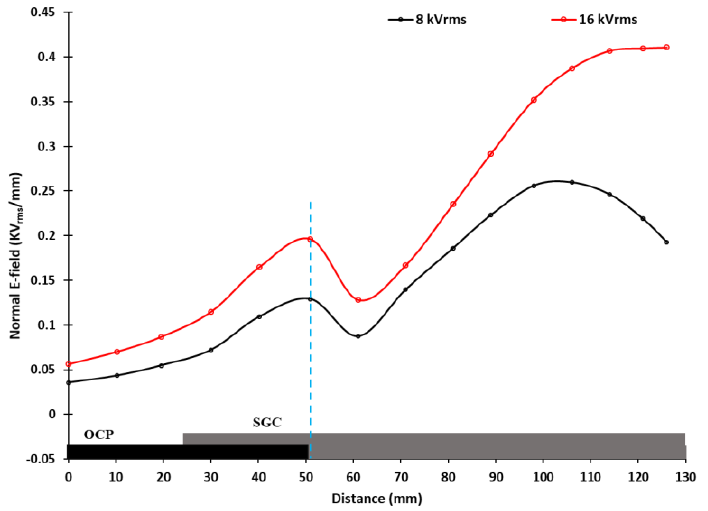
Figure 10. Distributions of the absolute value of E n obtained at the surface of the stress grading system for applied voltages of 8 kV rms and 16 kV rms .